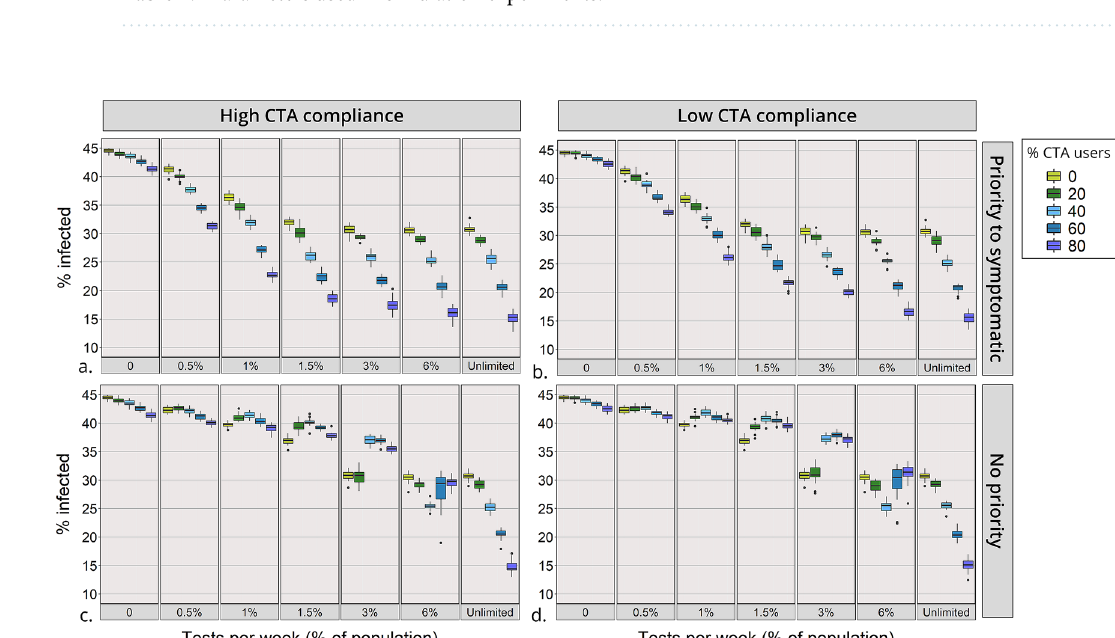
Figure 4. Percentage of the population infected during the course of epidemic. Scenarios vary by testing capacity (x-axis) and percentage of CTA users (boxplot’s colour). Diagrams are organized by testing policy and compliance with self-isolation of CTA users: ( a ) High compliance and priority for testing symptomatic cases; ( b ) Low compliance and priority for testing symptomatic cases; ( c ) High compliance and no priority for testing symptomatic cases; ( d ) Low compliance and no priority for testing symptomatic cases. The boxplots show the median and interquartile range of multiple simulation